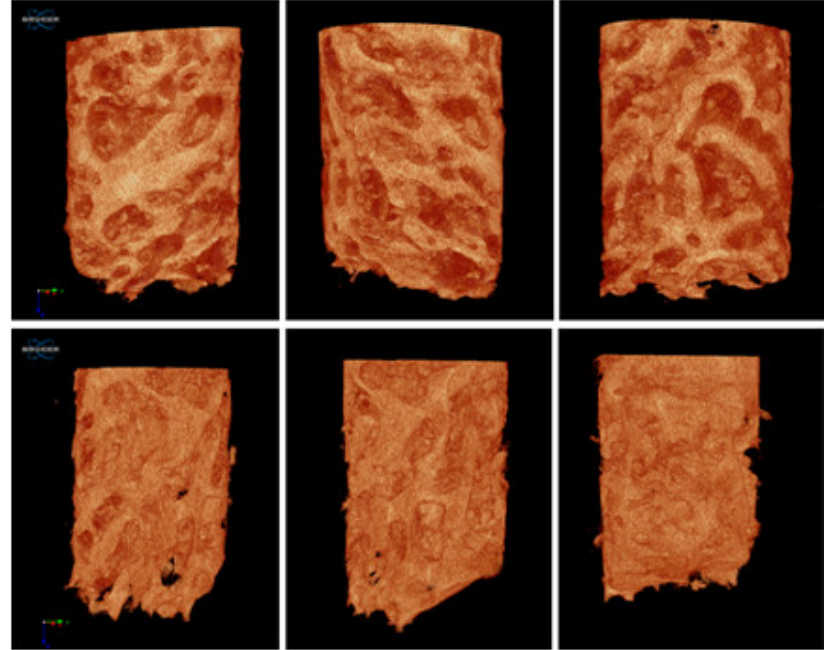
Figure 7. Micro-CT reconstruction of the harvested bone. In case no. 4.